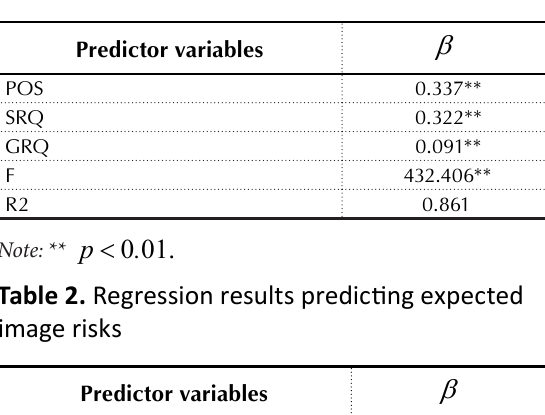
Table 1. Regression results predicting expected